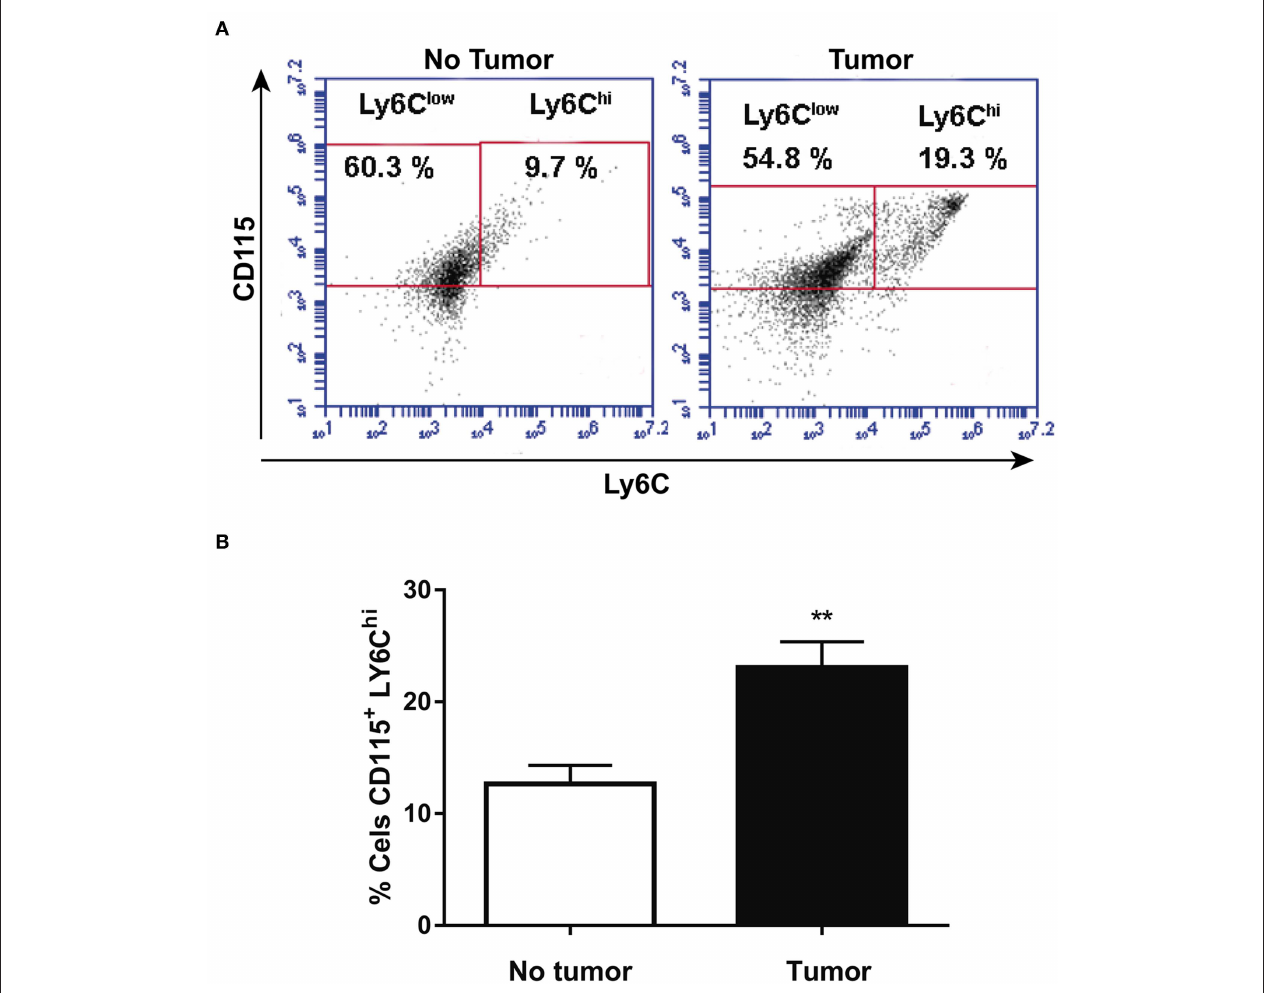
FIGURE 1 | Tumor-bearing mice present increased circulating population of CD115 + LY6C hi monocytes. After 14 days, animals with or without tumor, were anesthetized and blood was withdrawn by cardiac puncture. Thereafter, monocytes were isolated from the blood and analyzed by flow cytometry. (A) Representative dot plot used to quantify the percentage of CD115 + /LY6C hi population within the selected gate. (B) CD115 + /LY6C hi population ( n = 6). Data are expressed as mean ± SEM. ** p < 0.01 by unpaired t